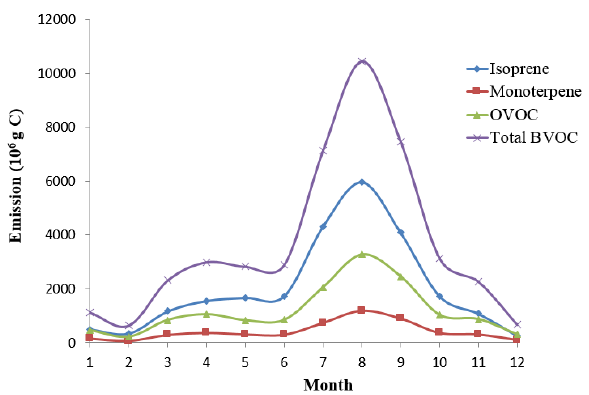
Figure 2. The monthly variations of BVOC emissions